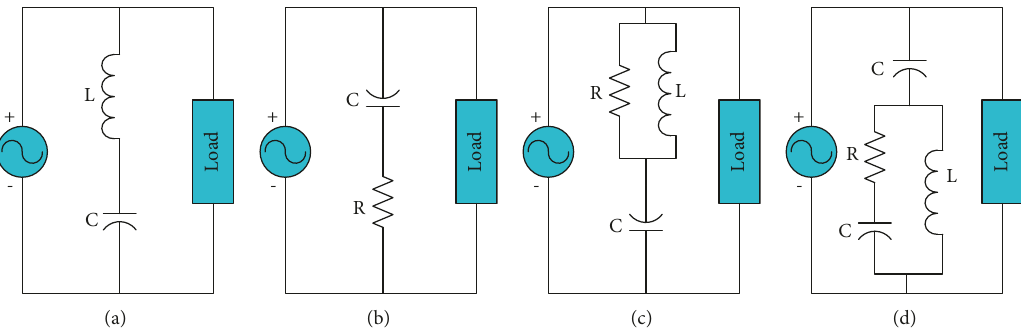
Figure 2: Configurations of passive power filters (a) single tuned (b) 1st order high-pass (c) 2nd order high-pass (d) 3rd order high-pass.